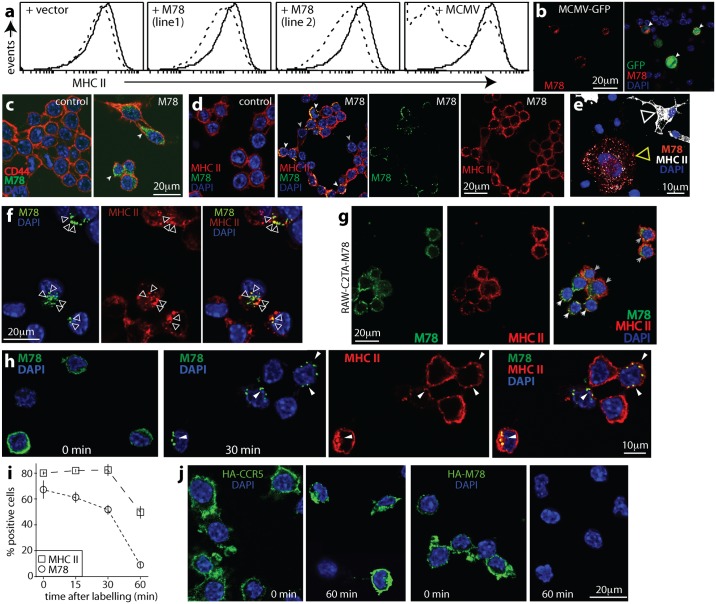
M78 relocalizes MHC II.a. Cloned RAW-C2TA cells were transduced with vector alone or with M78 (line 1 and line 2), or infected with MCMV-GFP (+ MCMV, 1 p.f.u. / cell, 72h), then stained for MHC II (dashed lines). Solid lines show uninfected, untransduced RAW-C2TA cells. The biphasic population with MCMV corresponds to GFP+ (MHC II-) and GFP- (MHC II+) cells. M78 transfection had much less effect than MCMV infection on cell surface MHC II expression. b. MCMV-GFP-infected RAW-C2TA cells were stained for M78. GFP was visualized directly. Nuclei were stained with DAPI. Arrows show example infected cells with M78 in vesicles. c. Untransduced (control) and M78-transduced RAW-C2TA cells were stained for M78 and CD44. Arrows show M78 staining, which did not co-localize with CD44. d. M78-transduced RAW-C2TA cells were stained for M78 and MHC II. M78 occupied intracellular vesicles, as did MHC class II in M78+ cells. White arrows show examples of co-localization. Grey arrows show M78- cells with MHC II on the plasma membrane. e. Macrophages grown from bone marrow were infected with WT MCMV (1 p.f.u. / cell, 24h), then fixed and stained for M78 and MHC II. The white arrow shows a typical uninfected MHC II+ cell. The yellow arrow shows a typical infected cell with MHC II in vesicles. >80% of vesicles were M78+MHC II+, <20% were M78+MHC II- and <1% were M78-MHC II+ (n>300). Thus there was significant endosomal M78 / MHC II co-localization (p<10-4 by Fisher's exact test). f. RAW-C2TA cells were transfected with a plasmid expressing HA-tagged M78. 3d later they were fixed, permeabilized and stained for M78 and MHC II. Nuclei were stained with DAPI. Arrows show examples of M78 and MHC II co-localizing in internal vesicles. g. Cloned RAW-C2TA-M78 cells were stained for MHC II and M78. White arrows show M78+ cells with MHC II in vesicles; grey arrows show cells with diffuse M78 staining and MHC II not relocalized. M78/MHC II co-localization was observed in >30% of transduced cells (n>500) and not in untransduced controls. h. RAW-C2TA cells were infected with HA-M78+ MCMV (4h, 37°C), incubated with rabbit anti-HA and rat anti-MHC II IgG (1h, 4°C), then washed and incubated at 37°C for the times indicated before fixation, permeabilization and staining with anti-rat (red) and anti-rabbit (green) antibodies. Nuclei were stained with DAPI. Stainings show the change in distribution of surface-labelled M78 from 0 to 30min, and at 30min M78 co-localization with internalized MHC II (yellow, arrows). i. Summary of staining results from h shows similar kinetics of surface-labelled M78 and MHC II loss. Cells were scored as stained or not regardless of internalization. Each point shows mean ± SEM of 5 fields of view and >100 cells counted. j. RAW-C2TA cells were transfected with plasmid expressing HA-tagged M78, or HA-tagged CCR5 as a control. 3d later they were incubated with rabbit anti-HA IgG (1h, 4°C), then washed and either fixed and permeabilized at once (0 min) or first incubated at 37°C (60 min). All cells were then stained with for rabbit IgG (green). Nuclei were stained with DAPI. HA-CCR5 detection was maintained over 60min, whereas HA-M78 detection was lost.